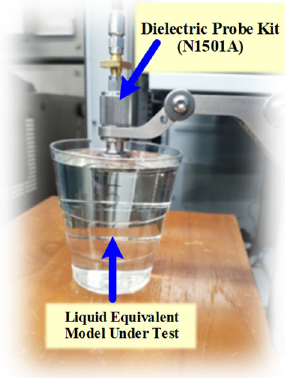
Figure 13. Measurement of the dielectric constants of equivalent liquid using the N1501A dielectric probe kit.